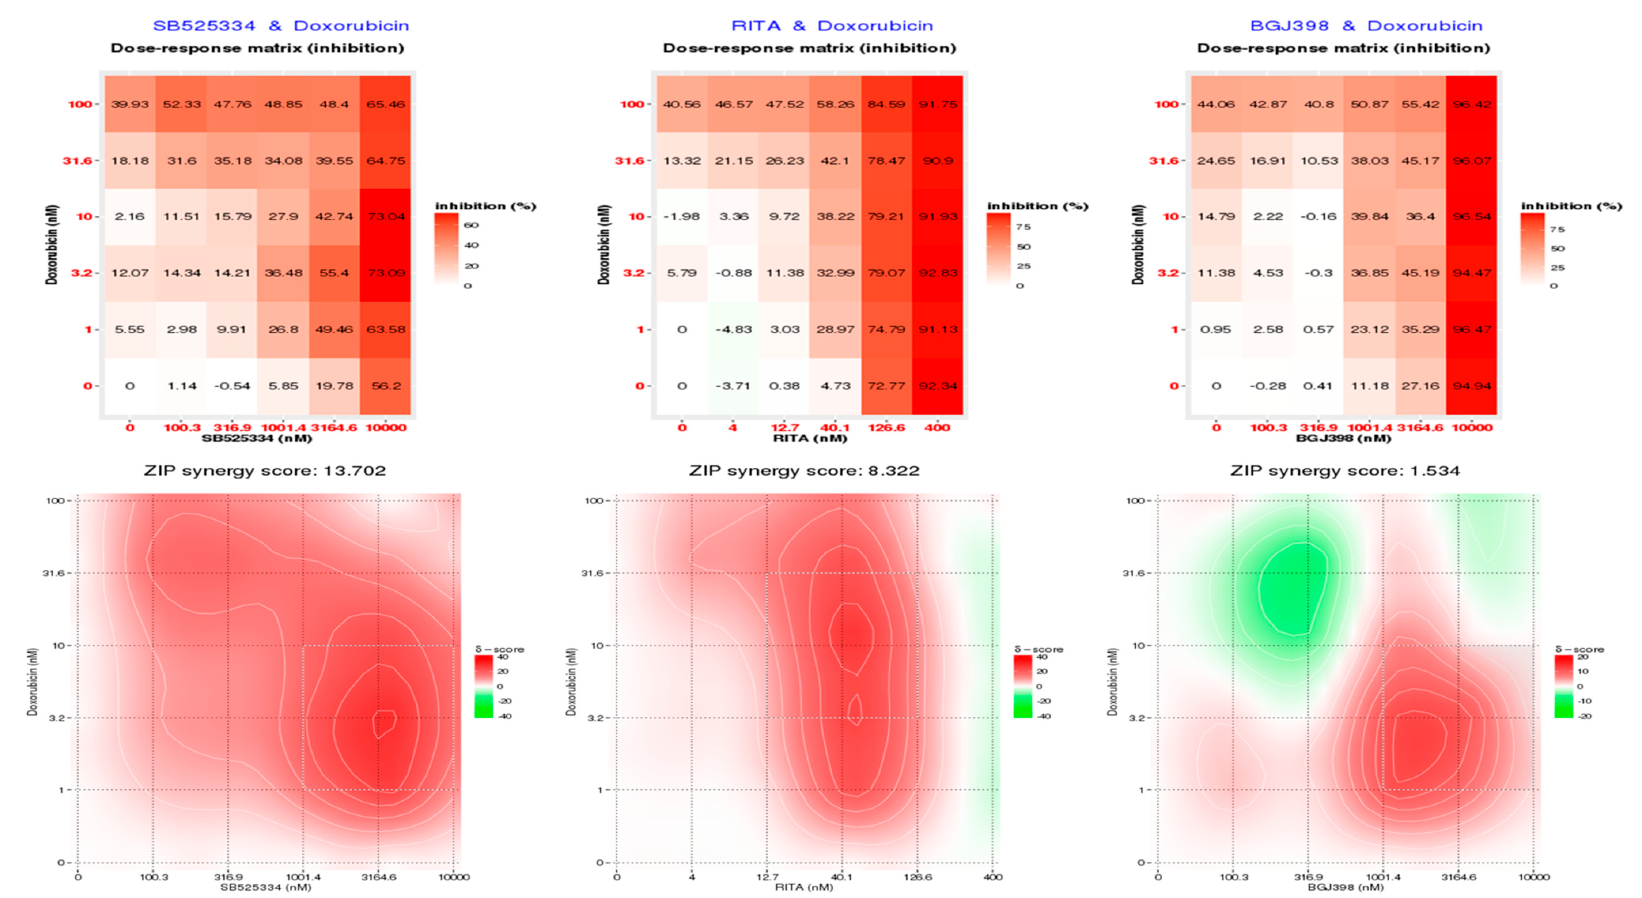
Figure 4. Dual combinations of doxorubicin with the inhibitors SB525334 and RITA synergistically inhibit MDA-MB-468. Cells were treated with an increased dose of doxorubicin up to EC50 together with either SB525334 (TGFBR inhibitor), RITA (MDM inhibitor), or BGJ398 (FGFR inhibitor). 2-D contour plots indicate areas of synergistic inhibition of cell viability by the red colour and antagonism by the green colour. Synergistic inhibition of MDA-MB-468 cell viability was found in the case of doxorubicin with SB525334 and RITA, while no synergy was detected in combination treatment of BGJ398 with doxorubicin. The top panel shows the data as a heatmap representing the raw dose–response matrix data for the percentage of cell inhibition for drug